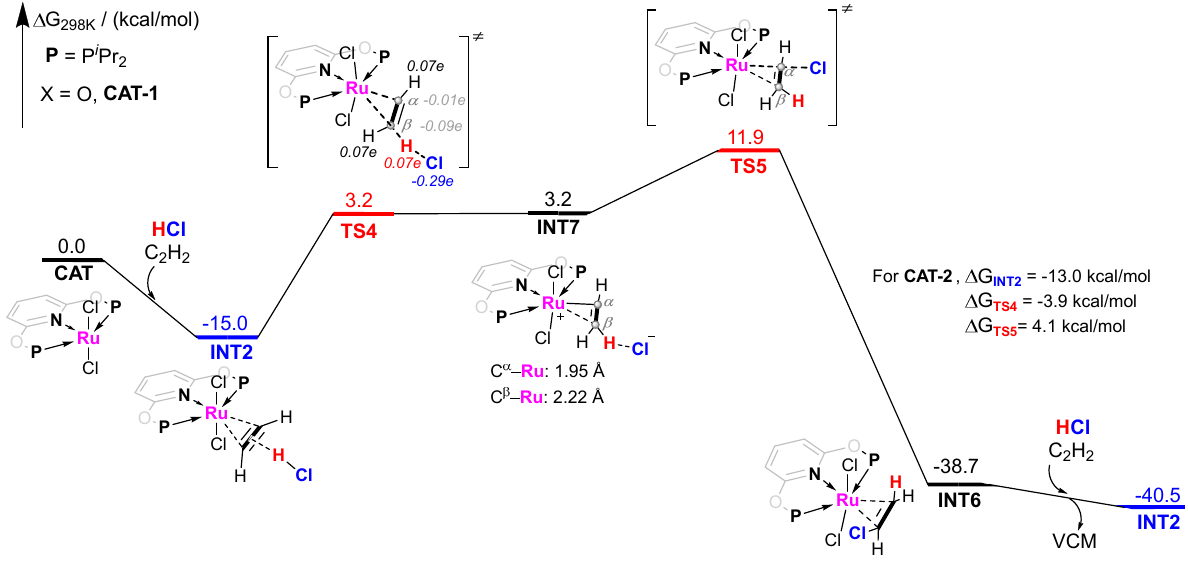
Figure 5. Gibbs free energy profile for molecular complex CAT − 1 catalyzed acetylene hydrochlorination mechanism pathway − 2. The Hirshfeld charge of important parts was shown in Italic fonts.